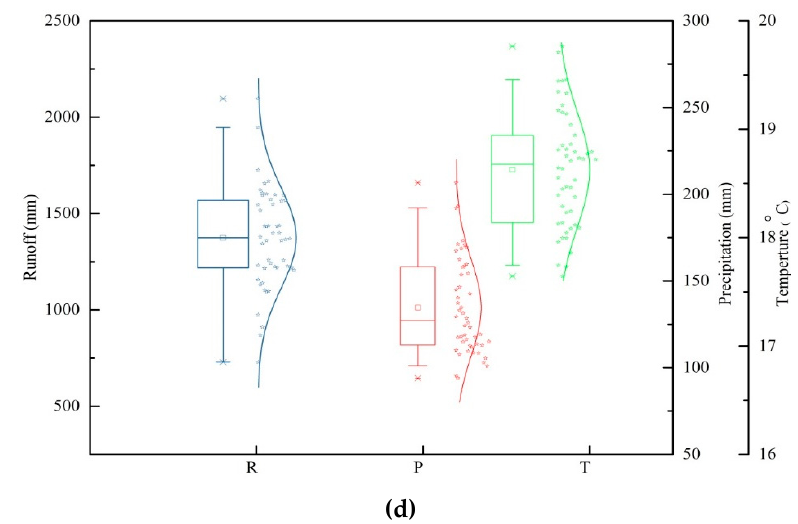
Figure 3. Box plot and distribution of precipitation, runoff and temperature of Zone II ( a ) monthly precipitation, ( b ) monthly runoff, ( c ) monthly temperature, ( d ) annual runoff, precipitation and temperature.